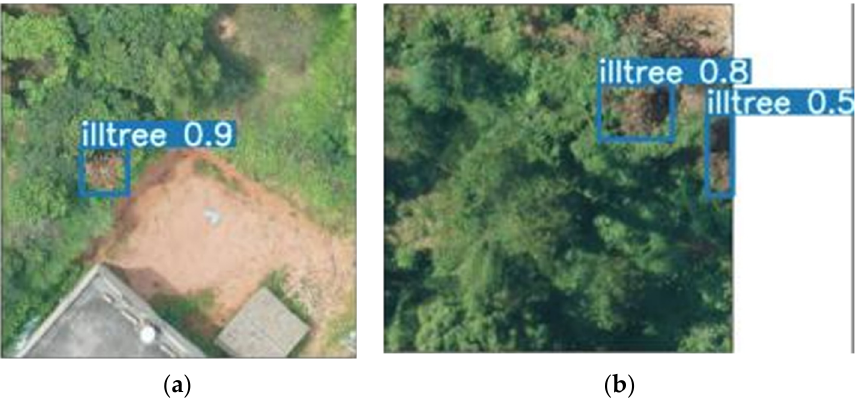
Figure 18. The picture of MobileNetv2-YOLOv4 detection. ( a ) Figure 1; ( b ) p 2.